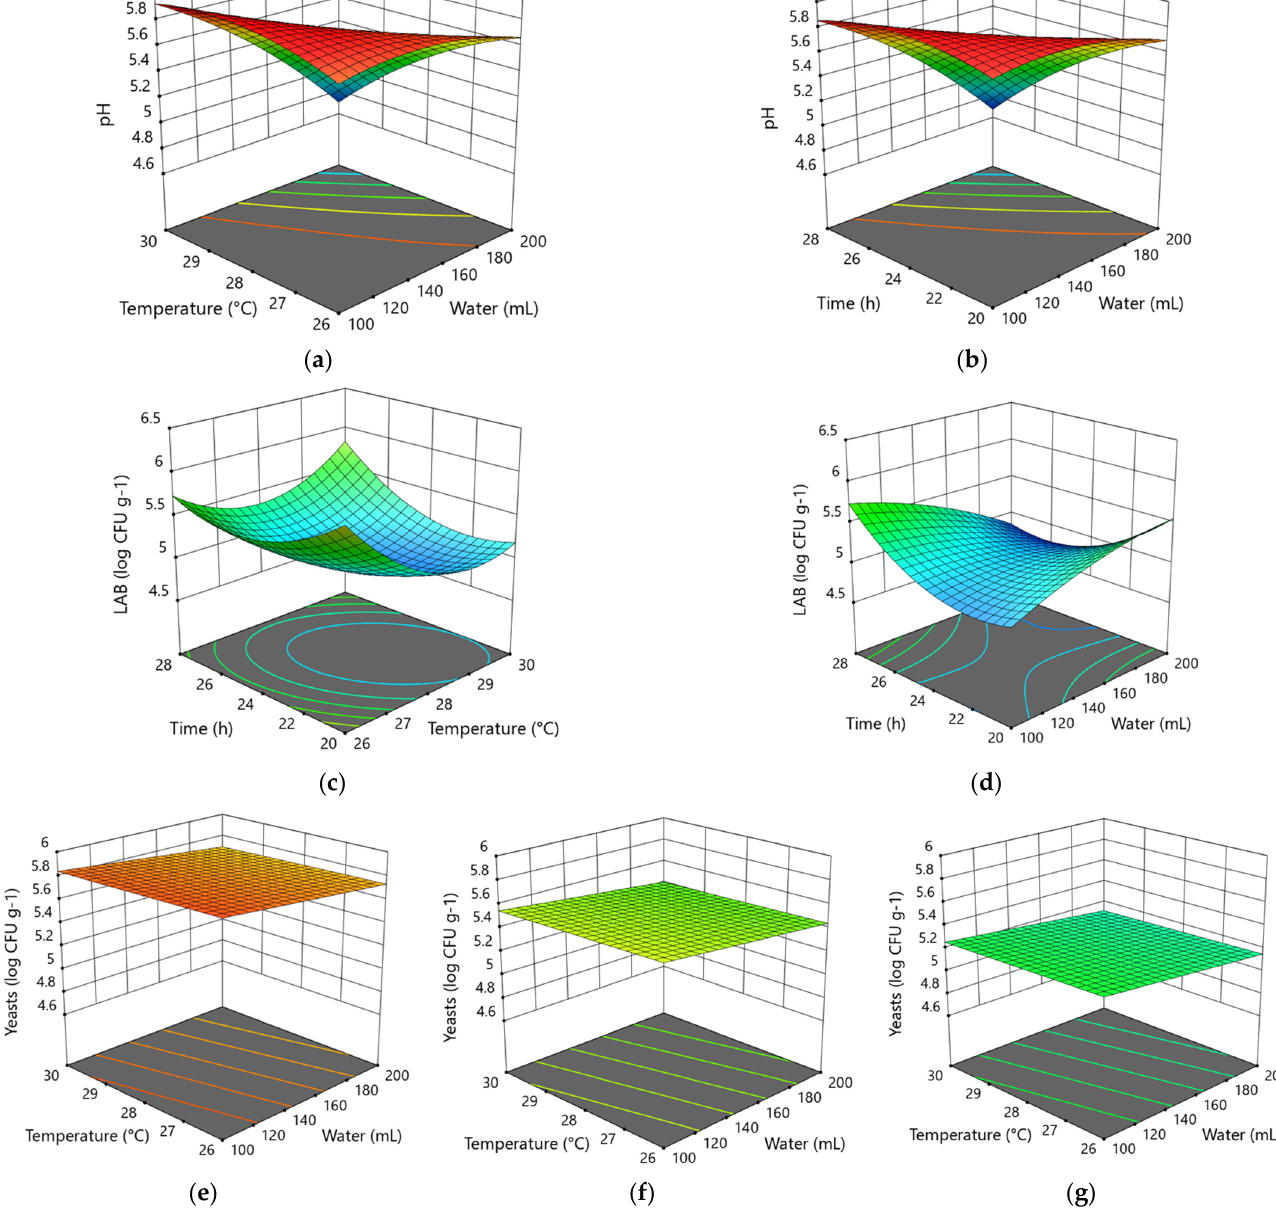
Figure 1. Response surface plots show the effect of temperature and water ( a ), time and water ( b ) on pH and of time and temperature ( c ), time and water ( d ) LAB log CFU g − 1 in the 1st backslopping step of fermentation; ( e – g )—shows time factor (20; 24; and 28 h) influence by yeasts log CFU g − 1 .